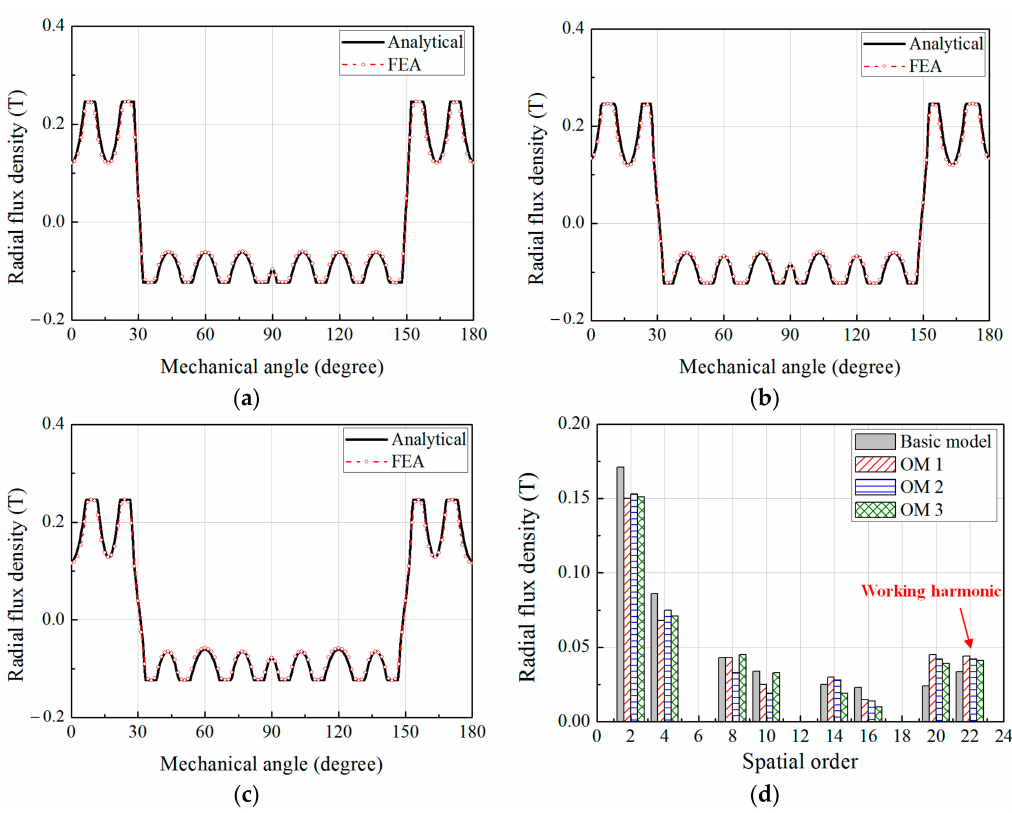
Figure 10. Flux density distributions in the air-gap due to the armature windings in the optimal models.